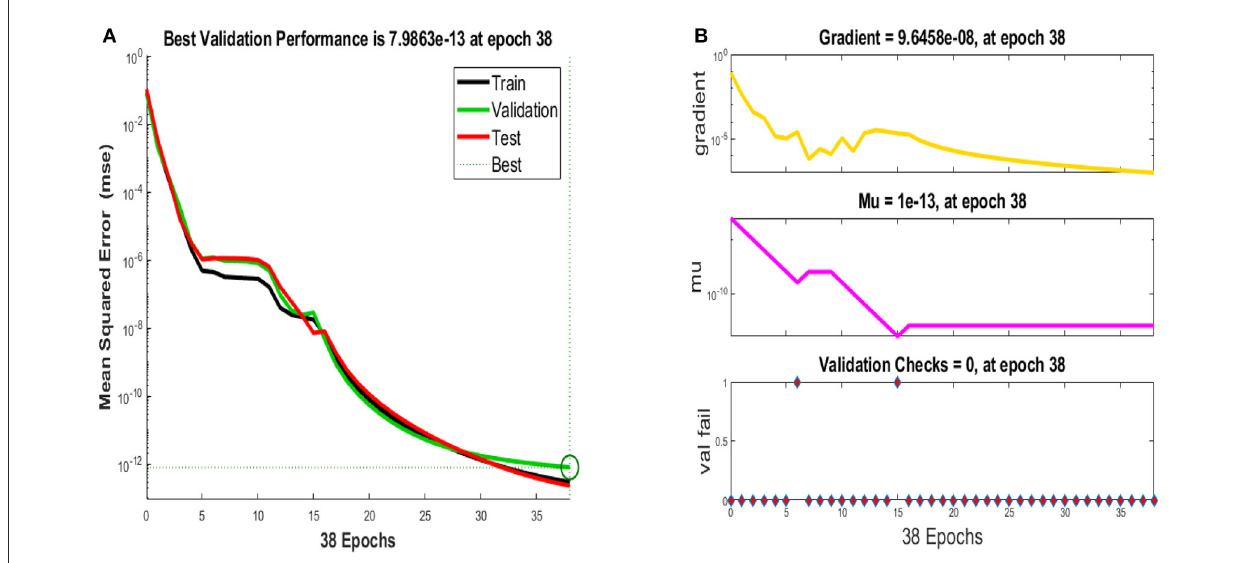
FIGURE2 MSE and STs performances for the HBV system. (A) MSE: Case 1. (B) EHs: Case